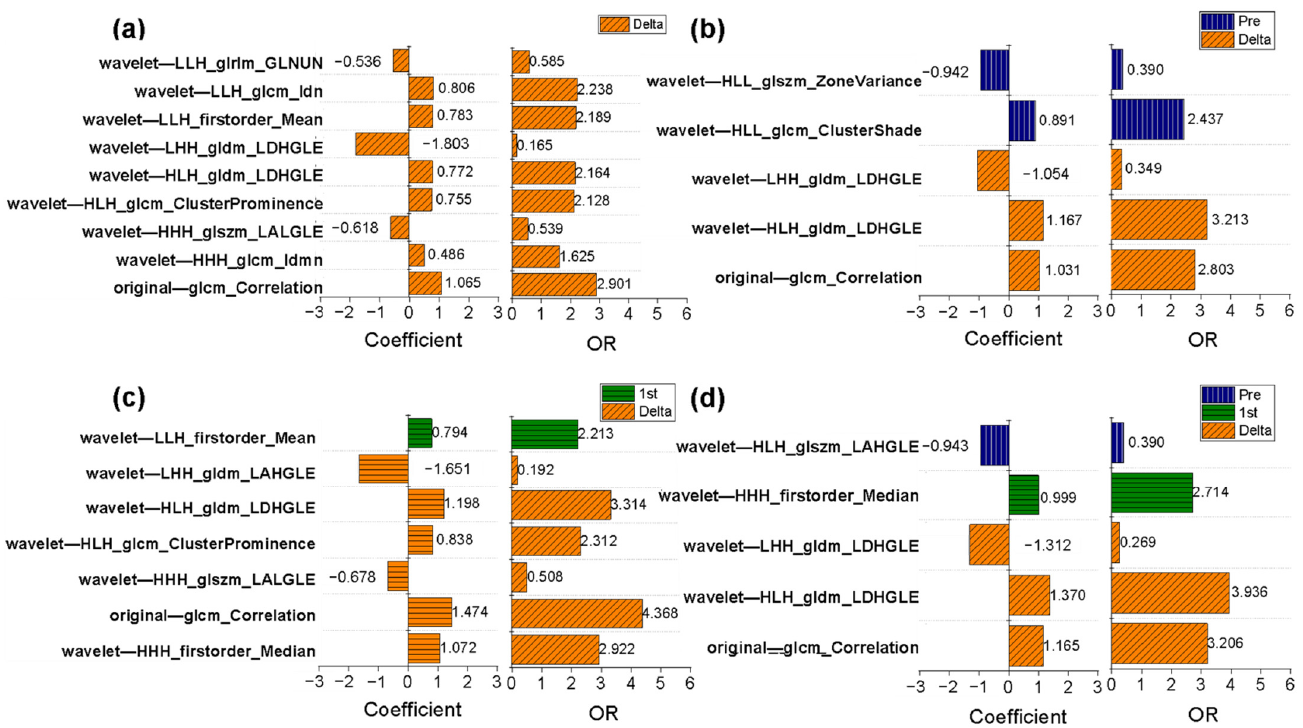
Figure 4. Odds ratio (OR) values and coefficients of the selected radiomic features in the delta-radi- omics model and the longitudinal fusion radiomic model based on CEe. ( a ) A total of 9 key features are in the delta-radiomics model, which is the optimal separate radiomic model. ( b ) The selected 5